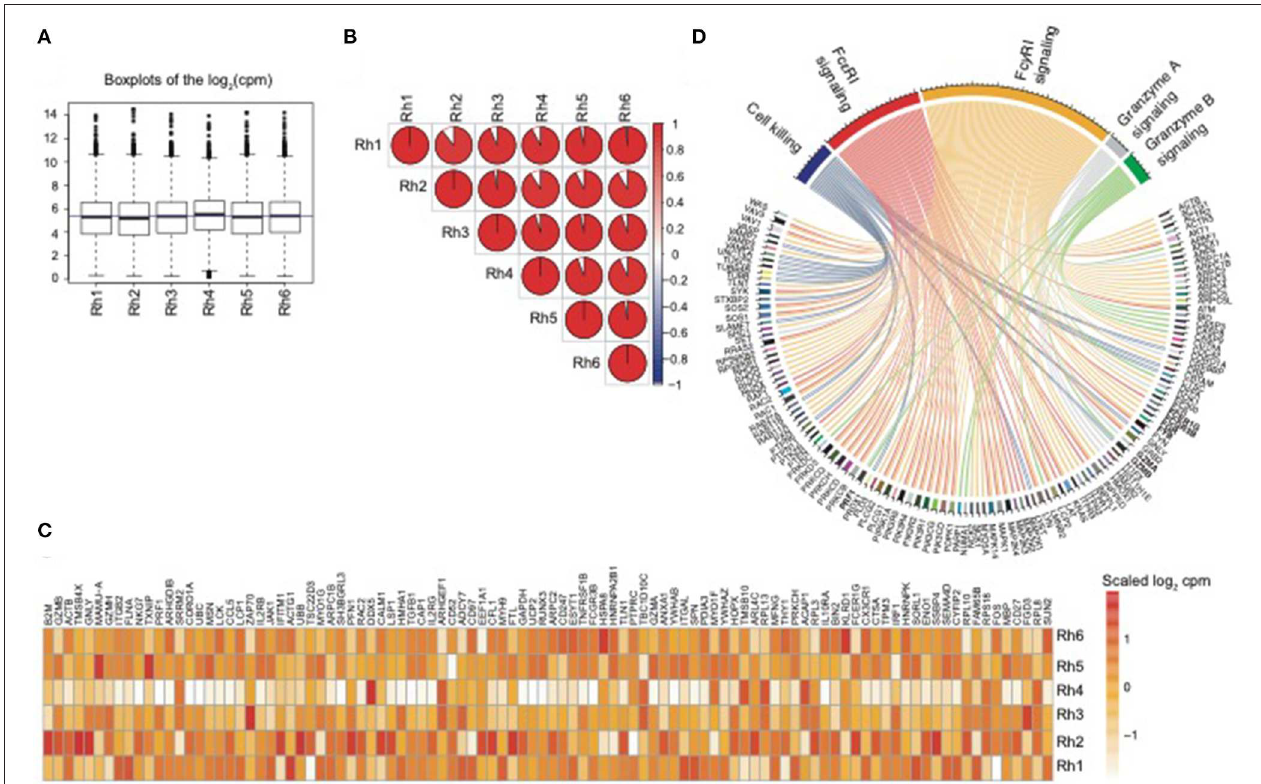
FIGURE 1 | NK RMtsig expression profile is consistent across all animals and shows enrichment of published NK cell markers and signaling pathways. (A) Boxplots showing the distribution of the log2(cpm counts) for each sample using the NK RMtsig. The blue horizontal line represents the median (cpm counts) across all animals. (B) Correlation plot showing the pairwise Spearman correlation of the NK RMtsig expression across all six animals. Pie charts represent the degree of the Spearman correlation ranging from blue (negative correlation) to red (positive correlation), where full pie corresponds to maximal correlation ( r = 1 and empty pie represents no correlation ( r = 0). (C) Heatmap representing the scaled log 2 (cpm count) of the top 100 highly expressed gene from the NK RMtsig. (D) Circular plot of major NK cell signaling pathways enriched in the NK RMtsig. Pathways were shown in different colors. Genes within each pathway were shown with edges of the same color.